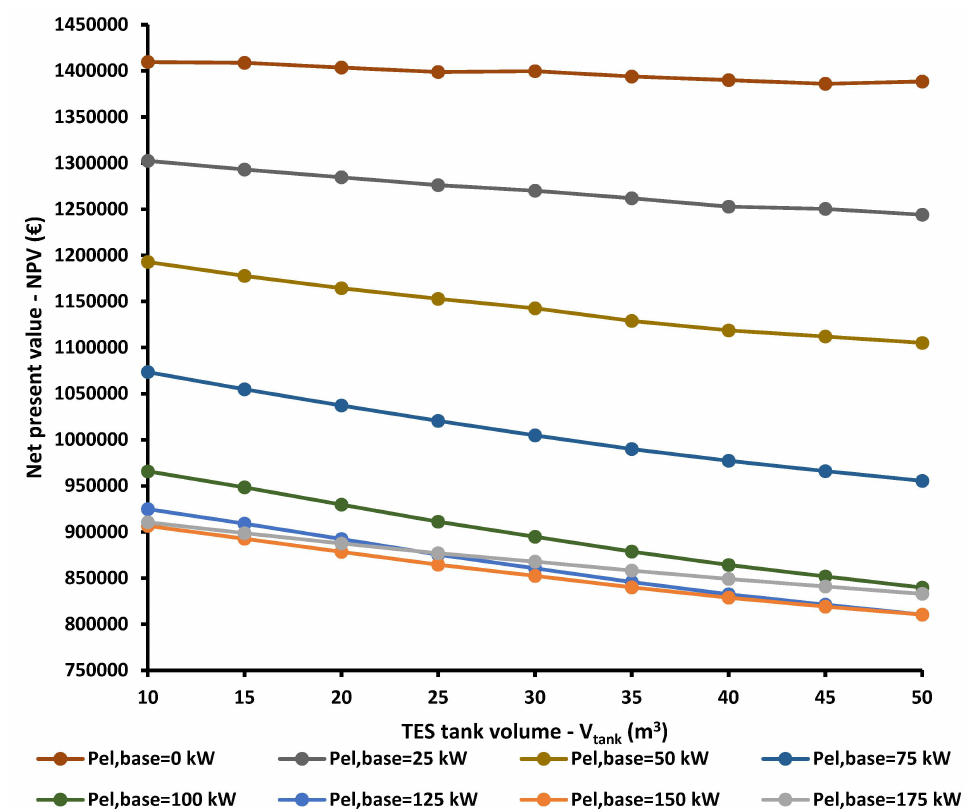
Figure 15. Net present value for different values of net electricity load and TES tank volume when the hydrogen price is equal to 25